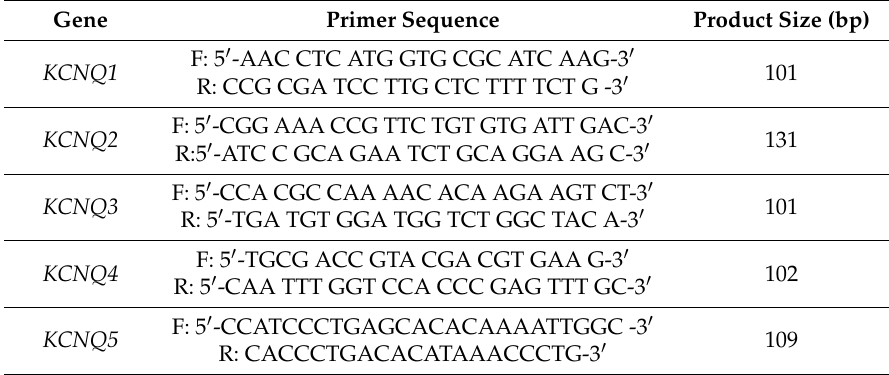
Table 1. Human qRT-PCR